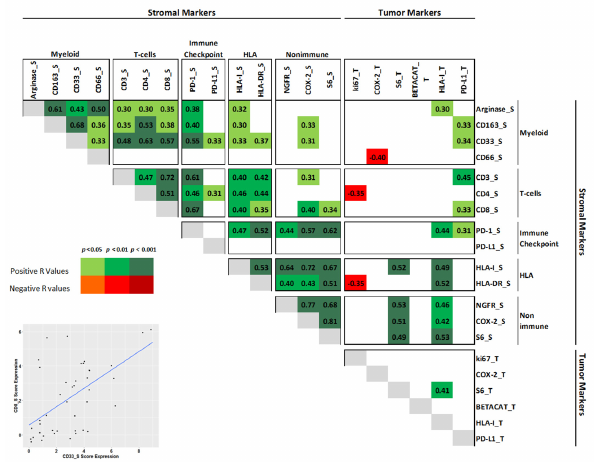
Figure 1. Binary associations of all investigated markers by Spearman correlation analysis. Only significant r values (either positive or negative) are shown. Expression of each marker was evaluated in the tumor (superscript T) or in the stroma (superscript S). On the bottom left: a representative scatter plot of CD8 S and CD33 S marker expression.